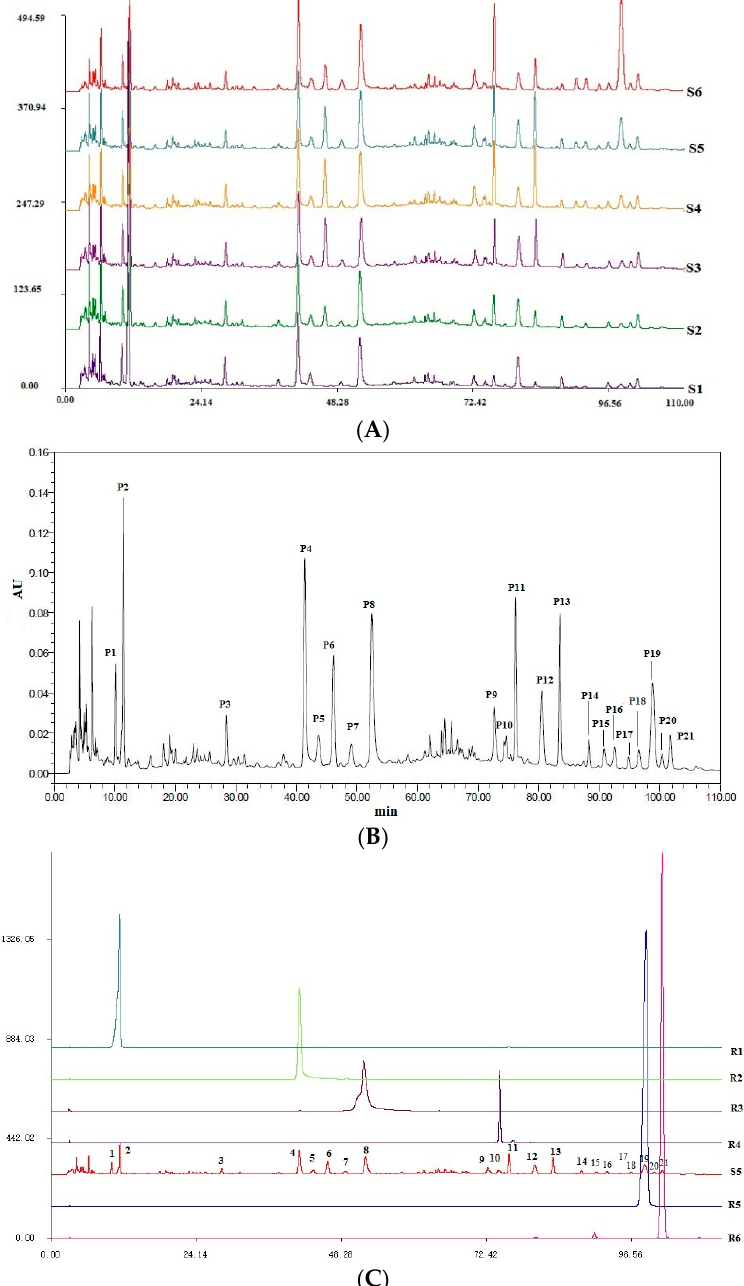
Figure 5. HPLC chromatograms. ( A ) HPLC chromatograms of six QBD extracts; ( B ) HPLC chromatogram of S5; ( C ) HPLC chromatograms of S5 and reference compounds. R1 (gallic acid); R2 (oxypaeoniflorin); R3 (paeoniflorin); R4 (verbascoside); R5 (paeonol); R6 (harpagoside).